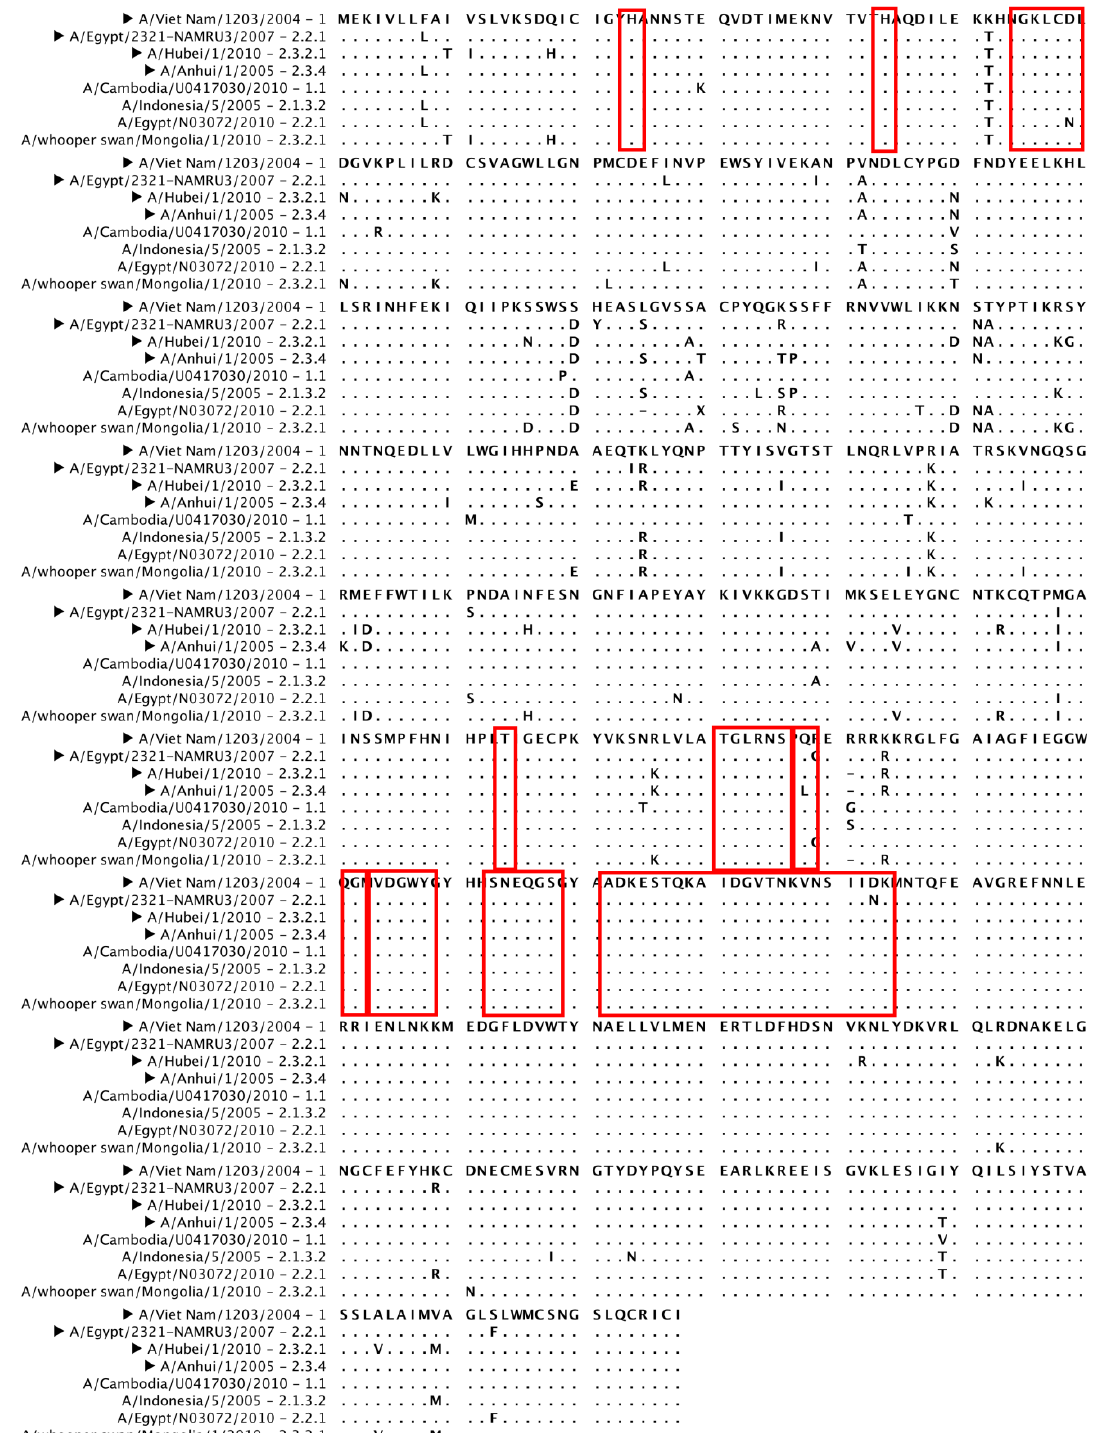
Figure 5. Amino acid sequence alignment of H5N1 HAs. The HA of several candidate vaccine viruses ( ► ) belonging to different H5N1 clades have been aligned to HAs of isolates belonging to several H5 clades currently circulating [90, 91]. Red boxes indicate the epitopes of the broadly-neutralizing mAbs described in this review able to neutralize H5N1